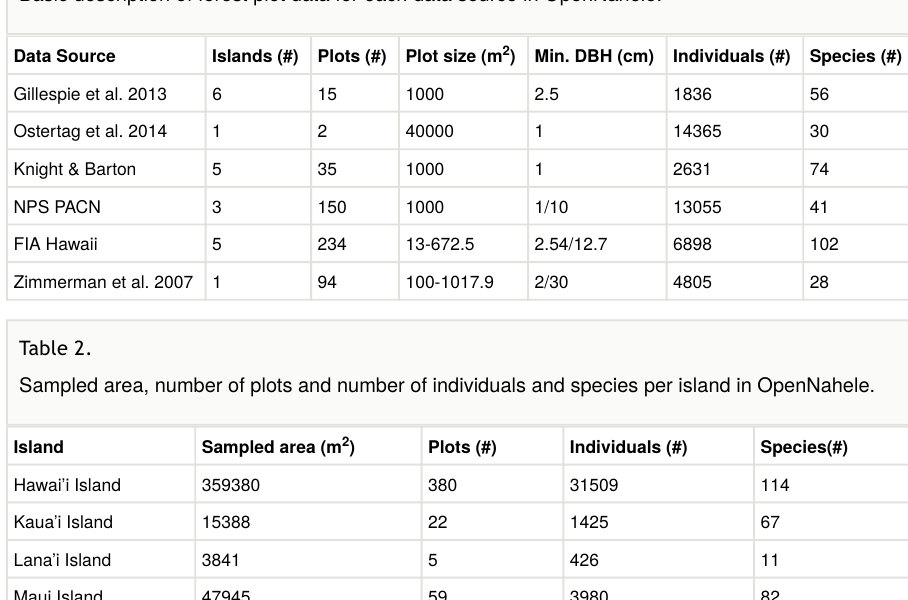
Basic description of forest plot data for each data source in OpenNahele.